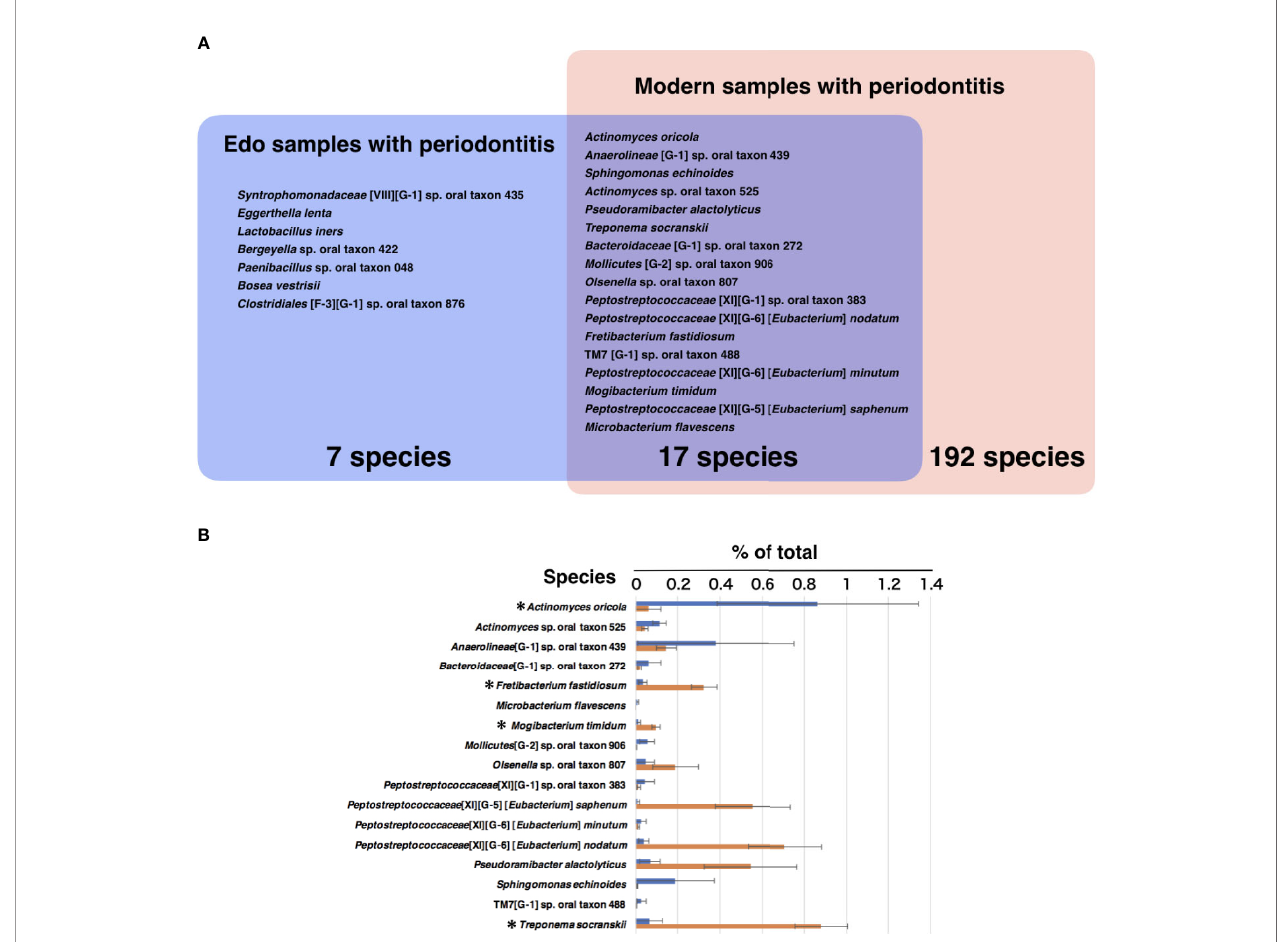
FIGURE 7 | The core microbiome of Edo and modern samples with periodontitis. (A) The model includes the species detected in Edo sample with periodontitis (blue), modern sample with periodontitis (red), and both sites (purple); red text indicates species existing in both co-occurrence networks. (B) The mean relative abundances of common species between Edo and modern samples with periodontitis. The bars show mean ± SE relative abundances.